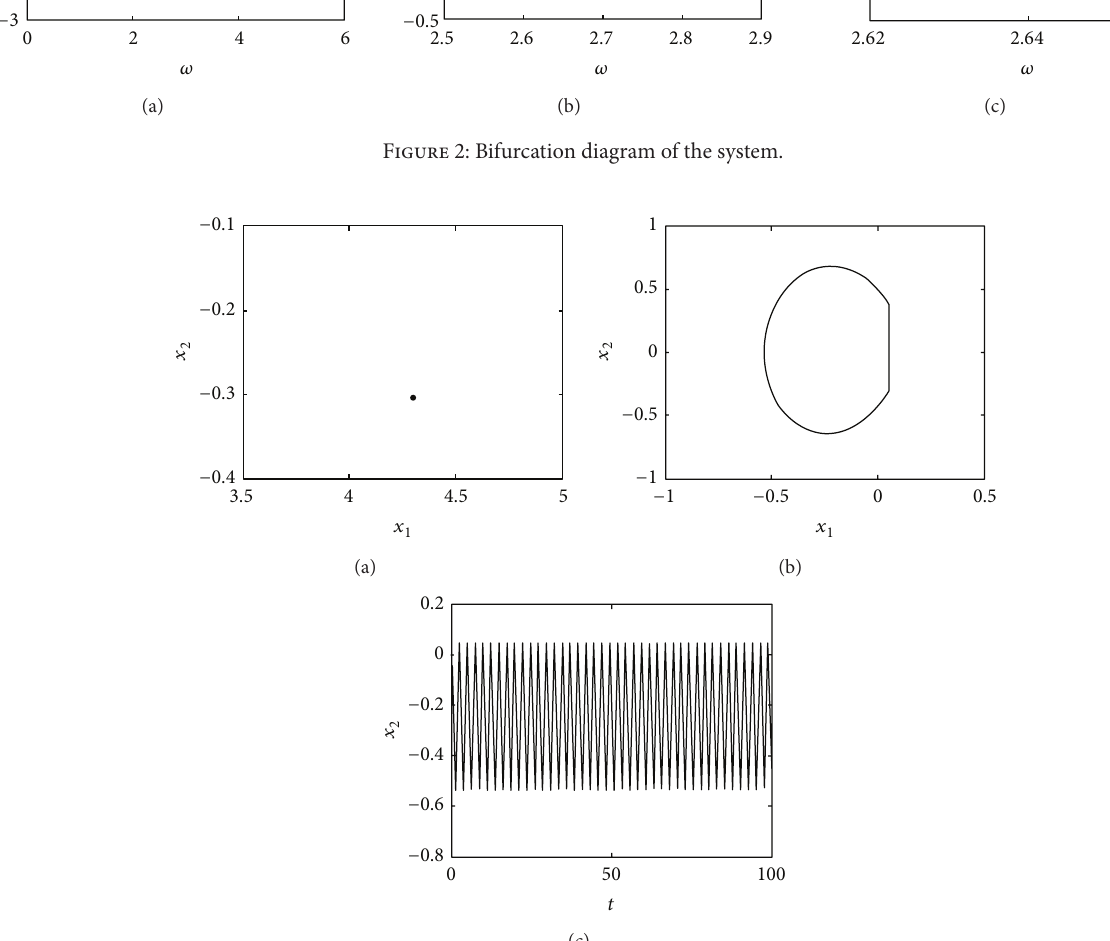
Figure 3: Poincar´e map, phase portrait, and time course diagram of the system with 𝜔 = 2.55